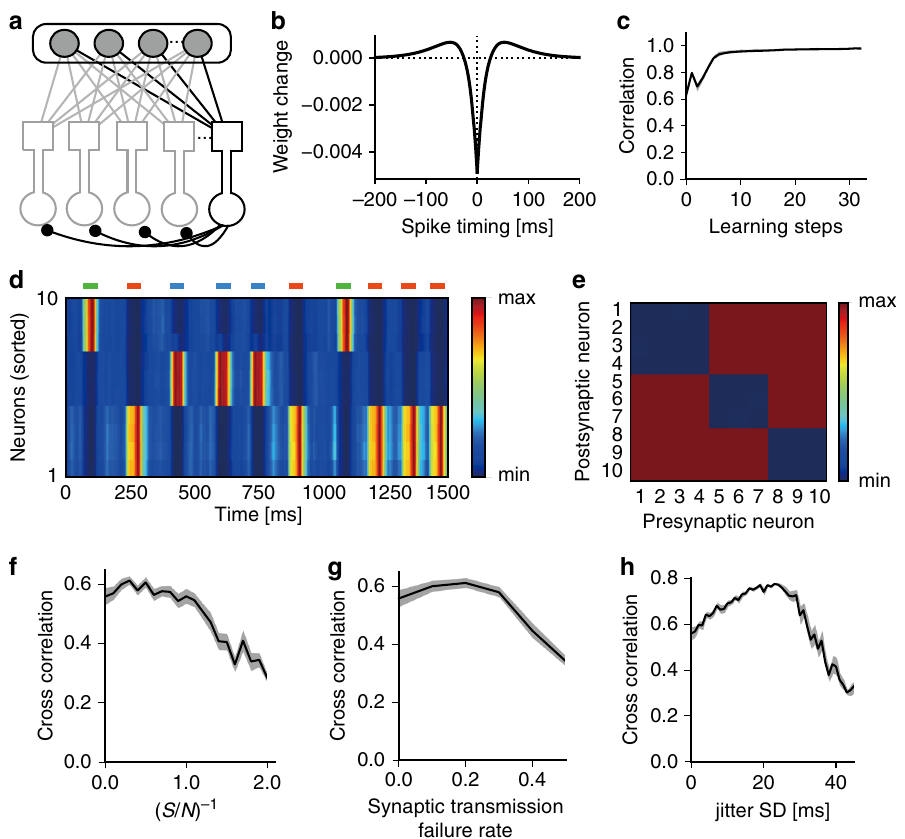
Fig. 2 Formation of temporal feature-speci fi c cell assemblies. a A competitive network of two-compartment neurons was used throughout this study. The input layer consists of Poisson spiking neurons and the output layer is comprised of the two-compartment neuron models. In this particular example, input neurons received presynaptic spikes trains similar to those shown in Fig. 1b. b Window function of the iSTDP implemented at lateral inhibitory connections. Here spike timing refers to the time advance of postsynaptic fi ring from the preceding presynaptic input. c The average correlation between the somatic and dendritic activities is plotted against learning step. Shaded area represents the s.d. d Phasic responses of output neurons are shown. Horizontal bars show the intervals in which three chunks (green, red, and blue) were presented. The responses are sorted according to the neurons ’ onset response times and indicate the emergence of chunk-speci fi c cell assemblies. e Post-learning synaptic weight matrix of lateral inhibition. The correlations between reference responses and actual output responses were evaluated in the presence of f contamination by background presynaptic spikes, g failure in synaptic transmissions, and h timing jitters in the target spiking patterns. Each reference response takes unity during the presentation of the corresponding chunk and zero otherwise. The ordinates refer to the inverse of the number ratio of background spikes to target-speci fi c spikes in f and the s.d. of spike timing jitters in h . The mean (thick line) and s.d. (shaded area) over 20 trials are shown. The correlations are shown for the maximally correlated pairs of cell assemblies and chunks (i.e., preferred